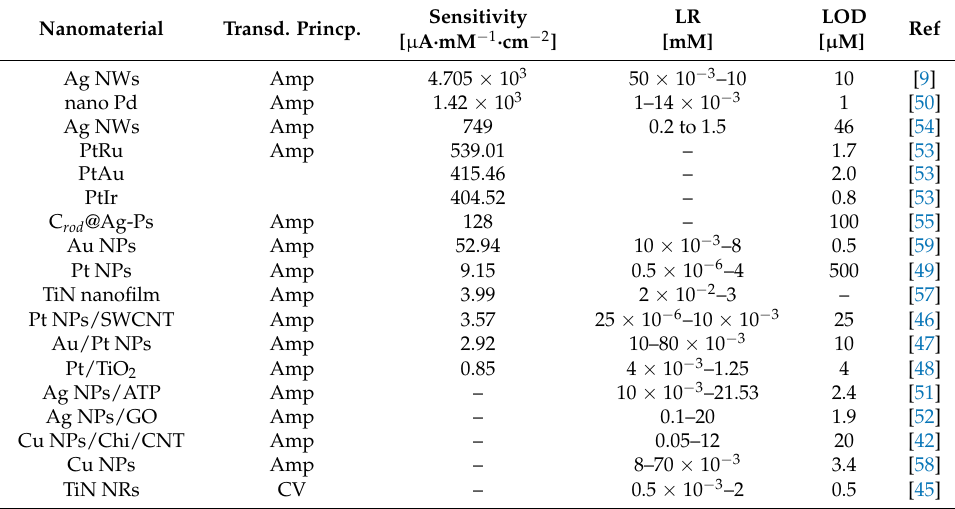
Figure 6. Chrono–amperometric response (left) of N-Co-MOF/GCE for the successive addition of 10 µ M of H 2 O 2 in 0.1 M PBS (pH = 7) under constant stirring, − 0.35 V. To the right, the figure shows the change in current at different concentrations of H 2 O 2 , the inset shows a TEM image of the Nitrogen-enriched MOF. Adapted with permission from [61]. Table 2. Metallic nanostructures based H 2 O 2